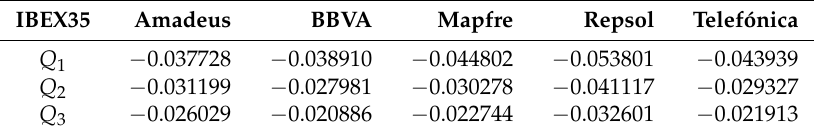
Table 8. The conditional value at risk VaR T 1 ( IBEX 35 ) for given IBEX35